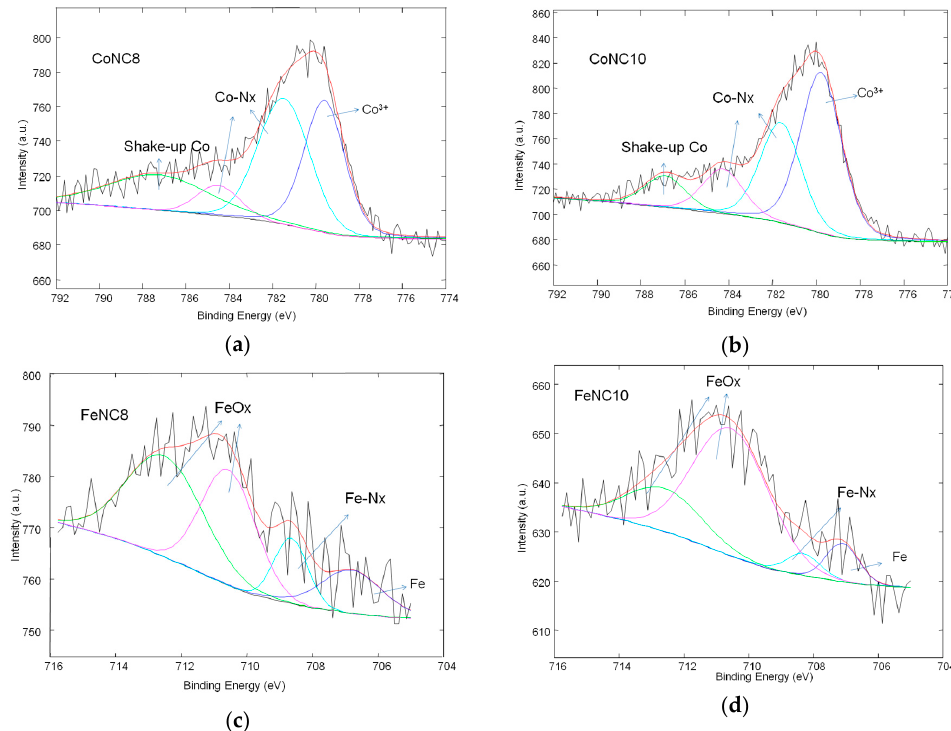
Figure 7. Deconvolution of Co 2p and Fe 2p high-resolution XPS spectra for the following catalysts: ( a ) CoNC8; ( b ) CoNC10; ( c ) FeNC8; and ( d ) FeNC10.